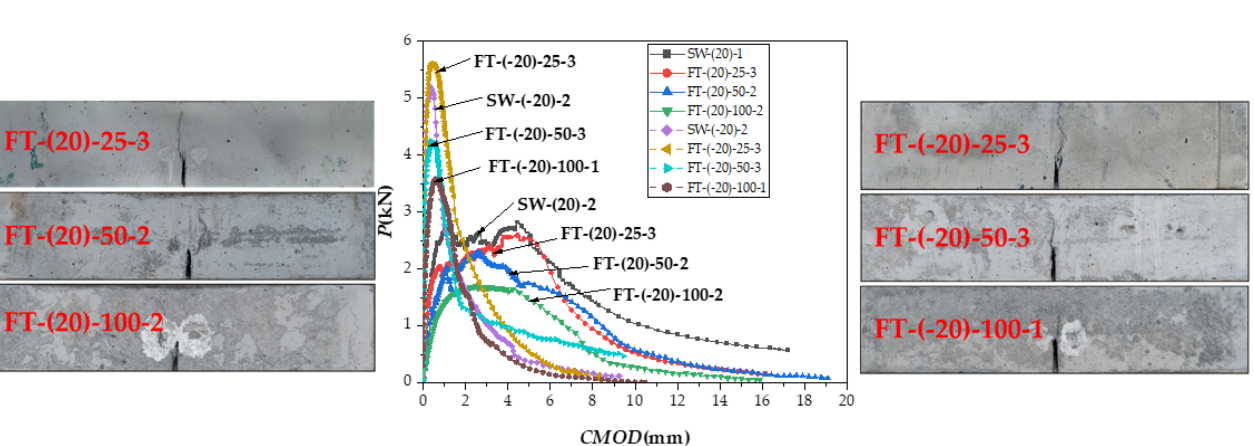
Figure 15. The number of freeze–thaw cycles increases, yet the inclination angle of the main crack and number of cracks around the prefabricated cut have not obvious regularity.